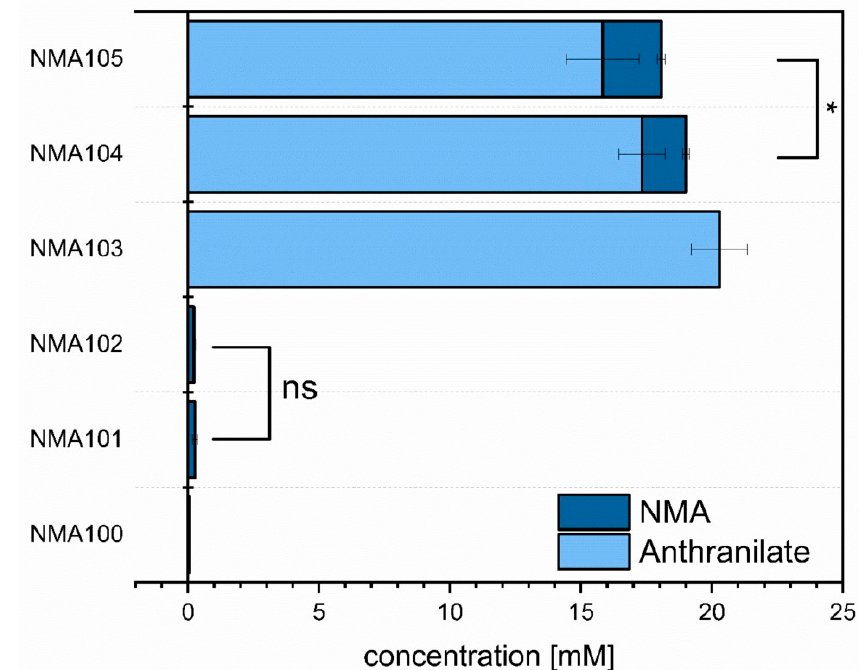
Figure 5. Production of anthranilate (light blue) and NMA (dark blue) by C. glutamicum strains NMA100 to NMA105. Cultivation was performed in minimal medium supplemented with 40 g·L −